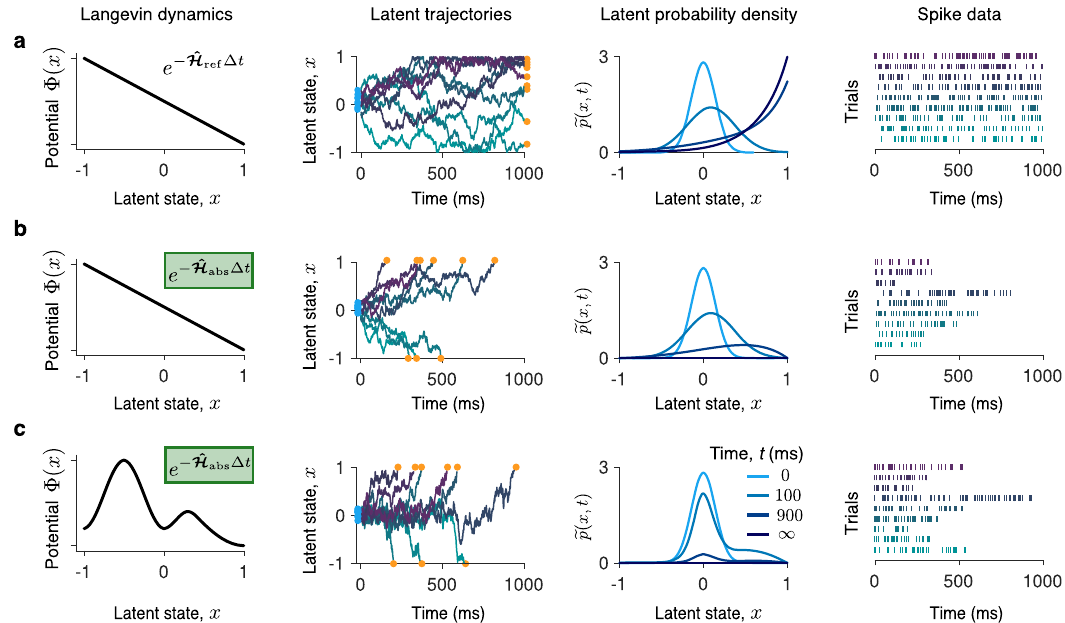
Fig. 2 Observation noise masks qualitative differences in non-stationary Langevin dynamics. Latent Langevin dynamics with: a a linear potential and re fl ecting boundaries; b a linear potential and absorbing boundaries; and c a non-linear potential and absorbing boundaries ( fi rst column). For each dynamics, nine example trajectories are displayed (color gradient, second column). In all cases, the initial latent state x ( t 0 ) (blue dots, second column) is sampled from the same density p 0 ( x ) (third column, t = 0). The time-propagation of the latent probability density e p ð x ; t Þ strongly depends on the potential shape and boundary conditions (third column). With re fl ecting boundaries ( a ), the latent trajectories terminate anywhere in the latent space at the trial end, whereas with absorbing boundaries ( b , c ), the latent trajectories always terminate at the boundaries (orange dots, second column). These qualitative differences in the Langevin dynamics are dif fi cult to discern from stochastic spike data (fourth column, colors correspond to the trajectories in the second